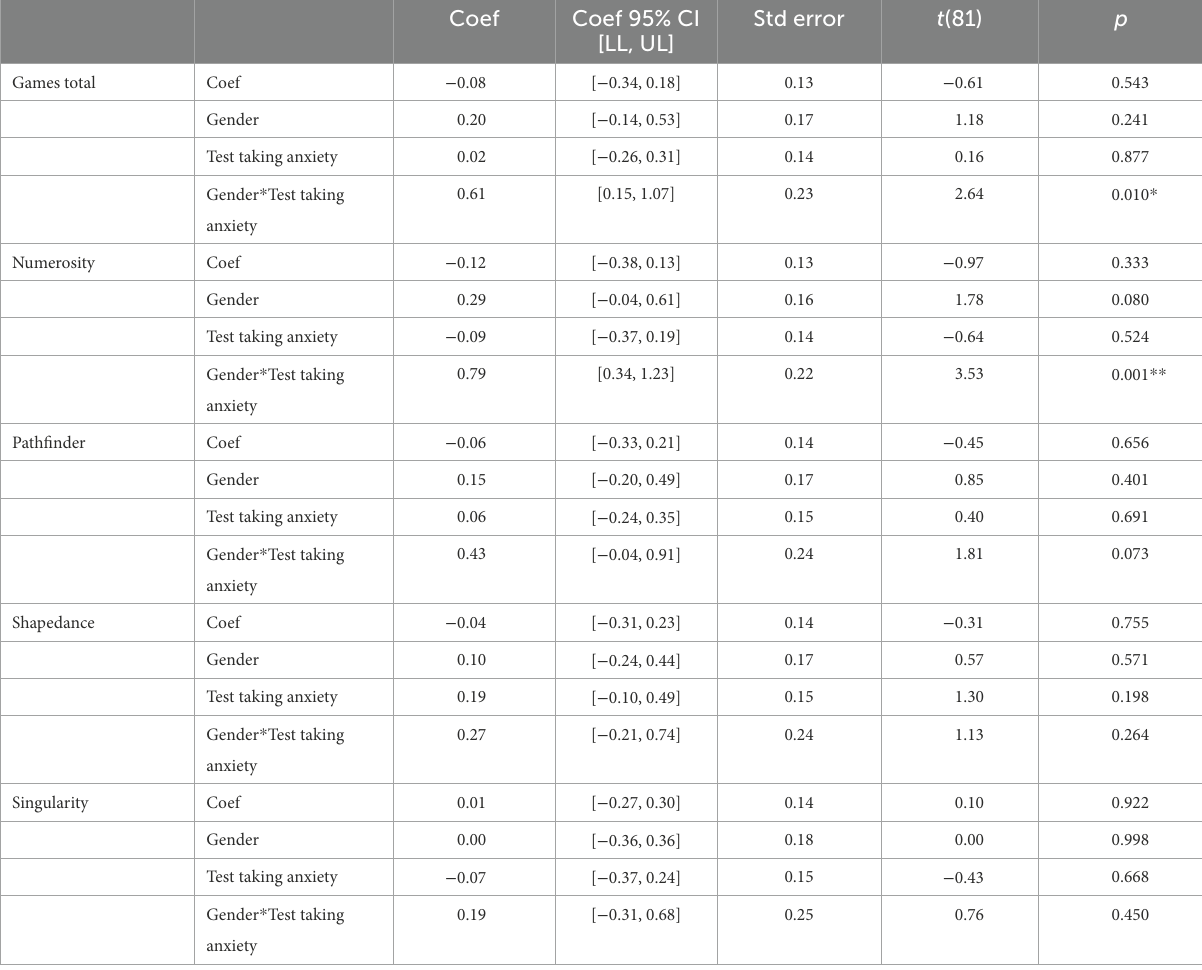
TABLE 7 Multiple regression predicting game performance from gender, test taking anxiety, and the interaction of gender and test taking